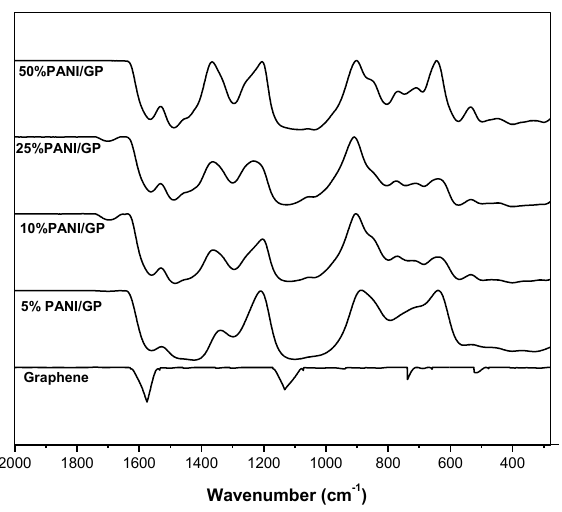
Figure 6. PANI/GP nanofiber at different wt % of GP to aniline.